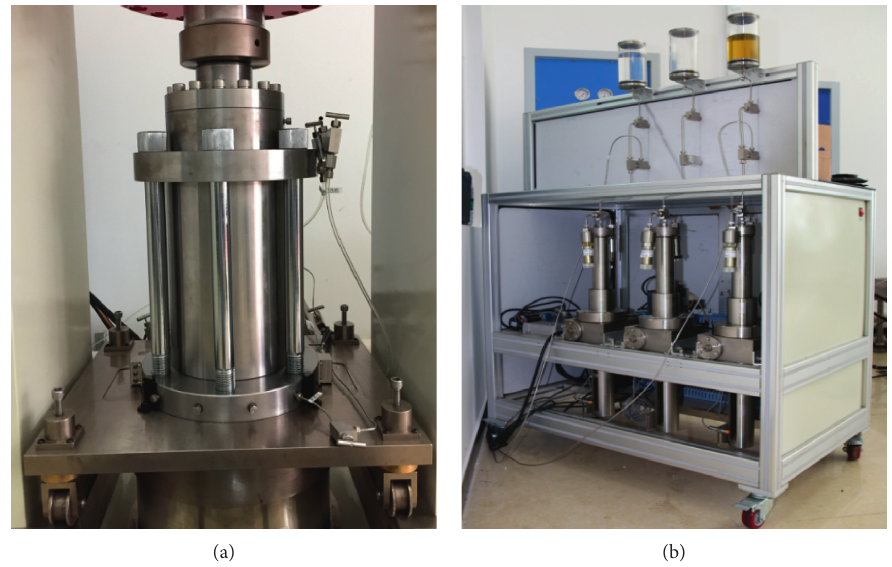
Figure 1: THMC multifield coupling triaxial rheological testing system. (a) Confining pressure chamber. (b) Servo unit for axial, confining, and pore pressures.